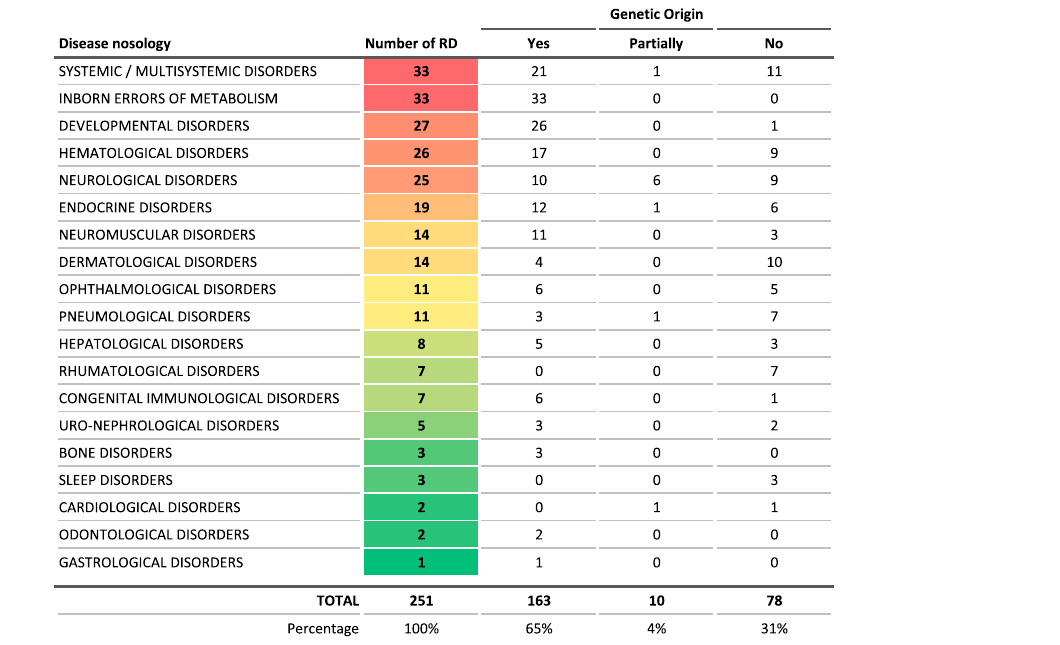
TABLE 3 | Distribution of the genetic origin or not of the diseases, by broad groups of